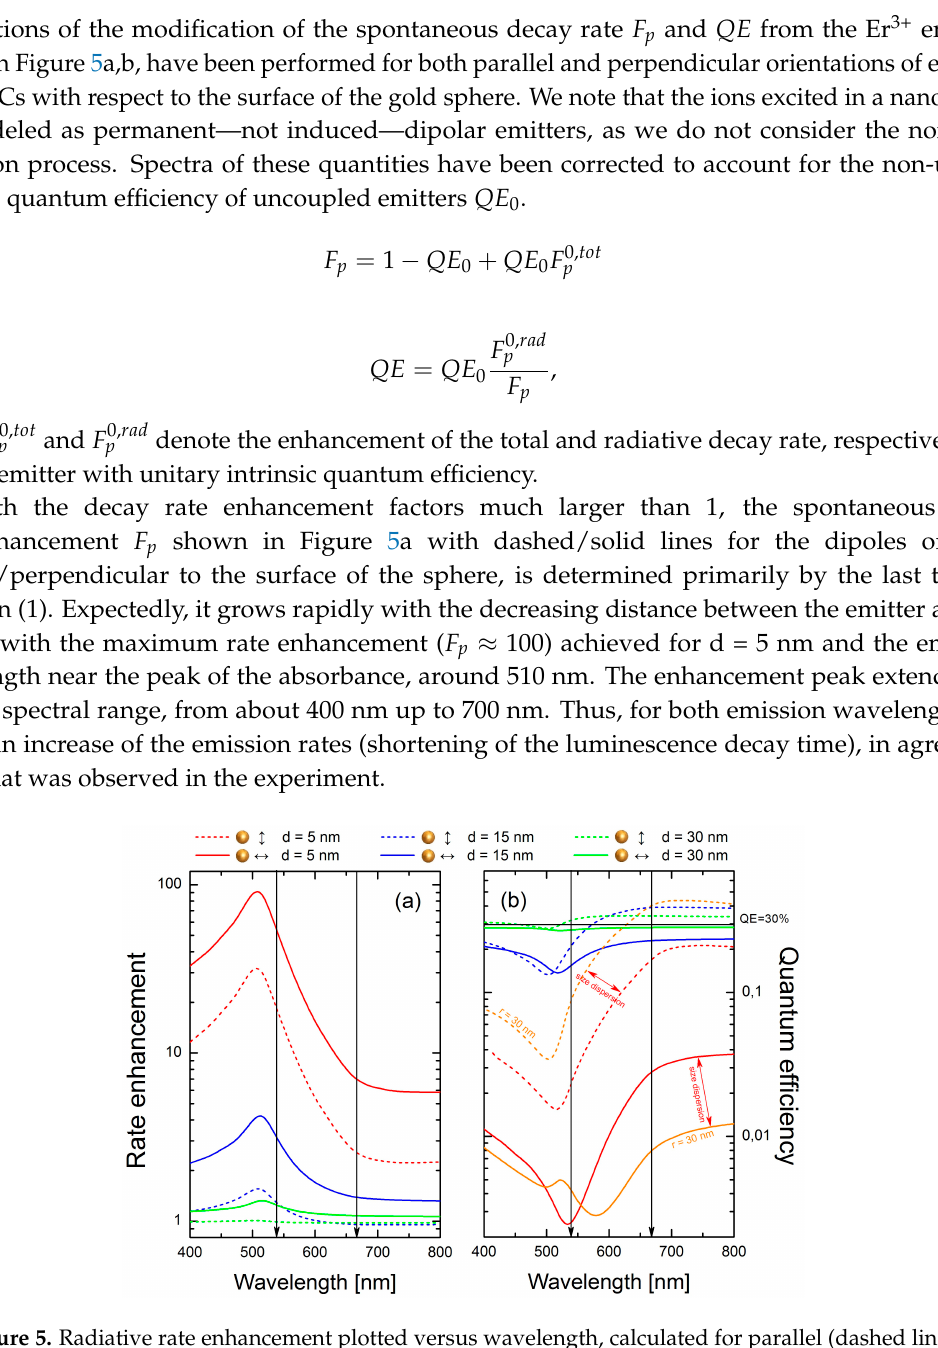
Figure 5. Radiative rate enhancement plotted versus wavelength, calculated for parallel (dashed lines) and perpendicularly (solid lines) oriented dipoles, at a distance d = 5 (green lines), 15 (blue lines) and 30 nm (red lines) from the surface of AuNP ( a ). Quantum efficiencies calculated for the same distances and dipole orientations are presented in ( b ). Calculations have been performed for an Au nanoparticle with radius r = 15 nm. For comparison, quantum efficiencies calculated for a bigger nanoparticle (r = 30 nm), with the emitter placed d = 5 nm from its surface are plotted in orange lines ( b ). Vertical arrows denote spectral position of the NCs emission lines.